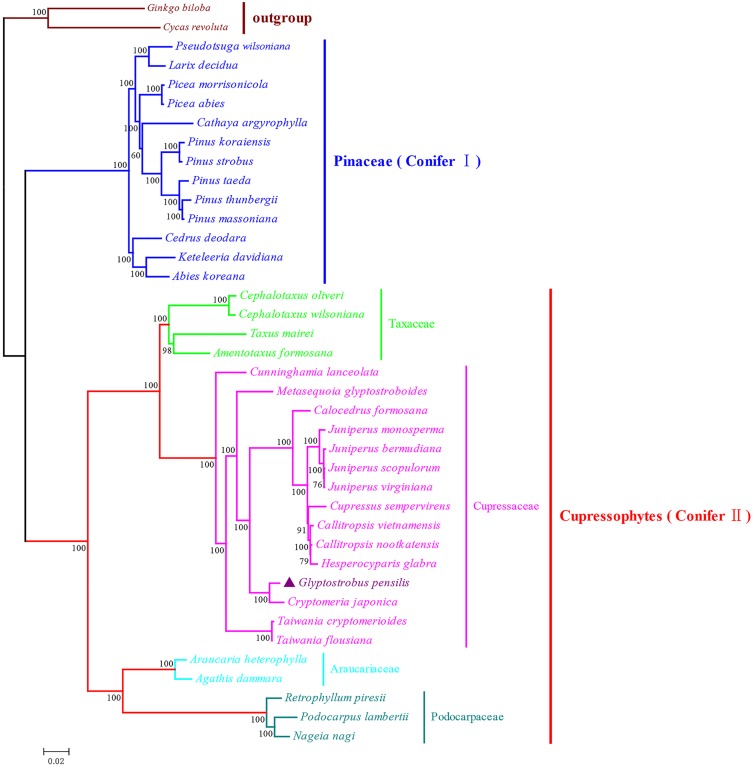
Phylogenetic analysis of conifer cp genomes.ML analysis was performed based on 47 cp protein-coding genes with a GTR + I + G model. G. biloba and C. revolute were set as outgroups. Support values for each branch based on a bootstrap analysis of 1,000 nonparametric replicates are shown. The scale of branch length is indicated in the bottom left corner.